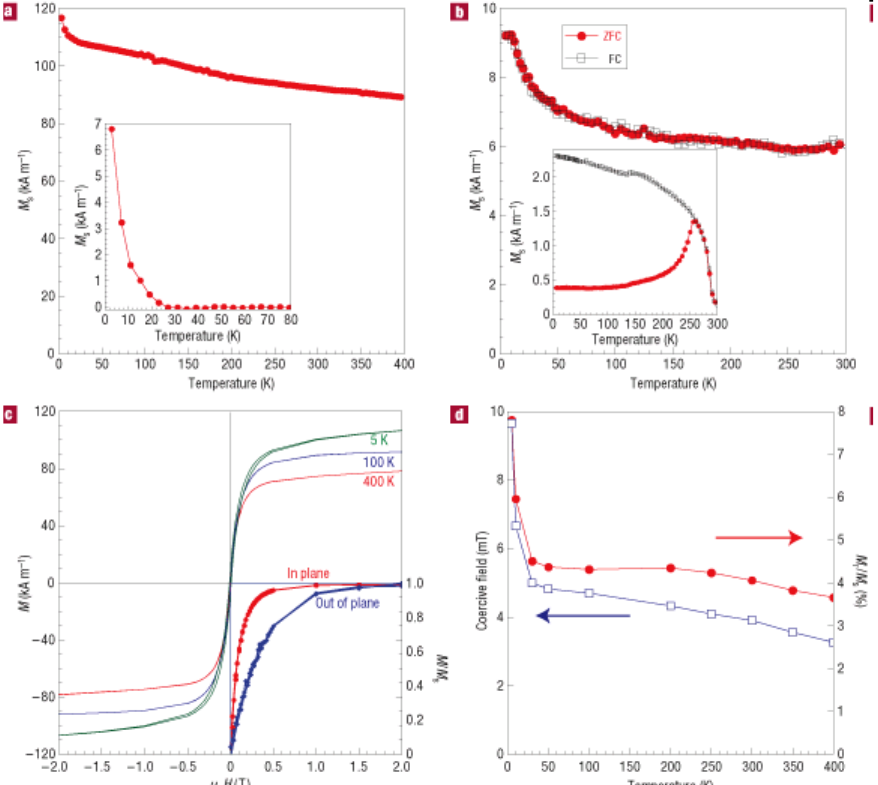
Figure 9 . (a) Temperature dependence of the saturation magnetization measured at 2 T. The inset shows the extrapolated matrix signal at low temperature after subtracting the nanocolumns magnetic signal. (b) ZFC-FC measurements carried out at 0.01 T. Both curves superimpose. Inset: ZFC-FC curves after 15-mins annealing at 650 ◦ C. (c) Magnetization loops at 5, 100 and 400 K, after subtracting the diamagnetic contribution from the substrate. The inset demonstrates the easier saturation in-plane at 250 K. (d) Coercive field and remanent magnetization versus